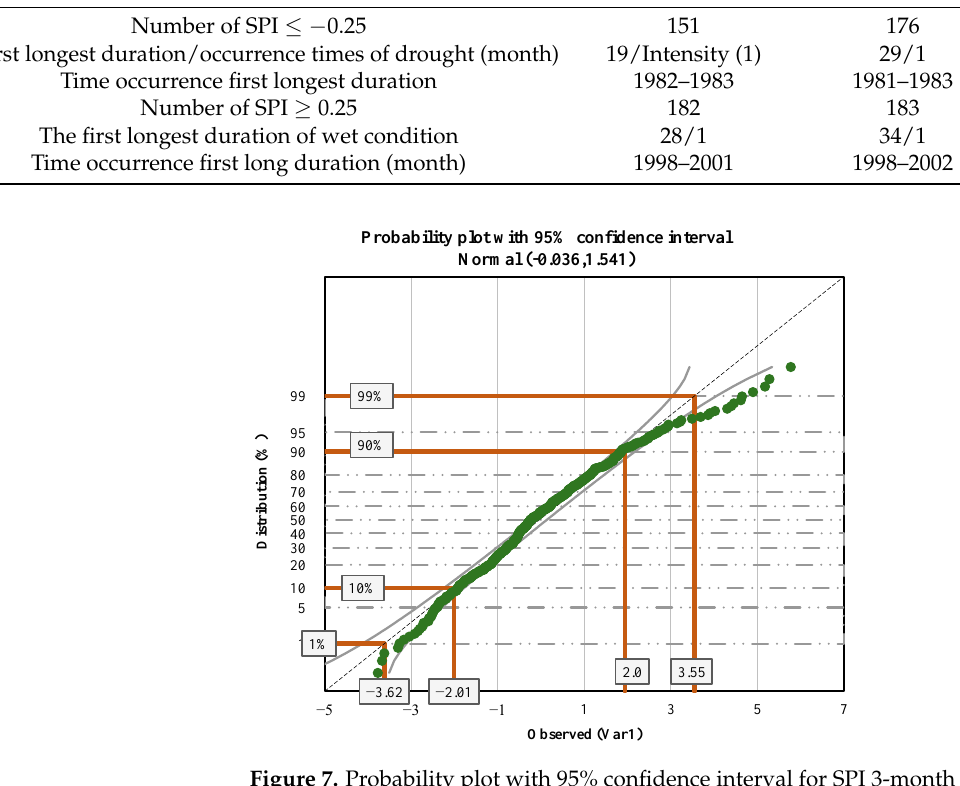
Figure 7. Probability plot with 95% confidence interval for SPI 3-month drought pattern.